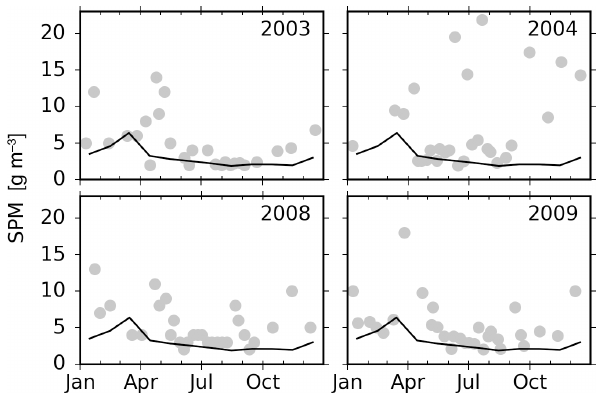
Figure B2. SPM concentrations measured (gray dots) and the monthly climatologies used as model forcing (black line) at the Noordwijk-10 station (location shown in Fig.